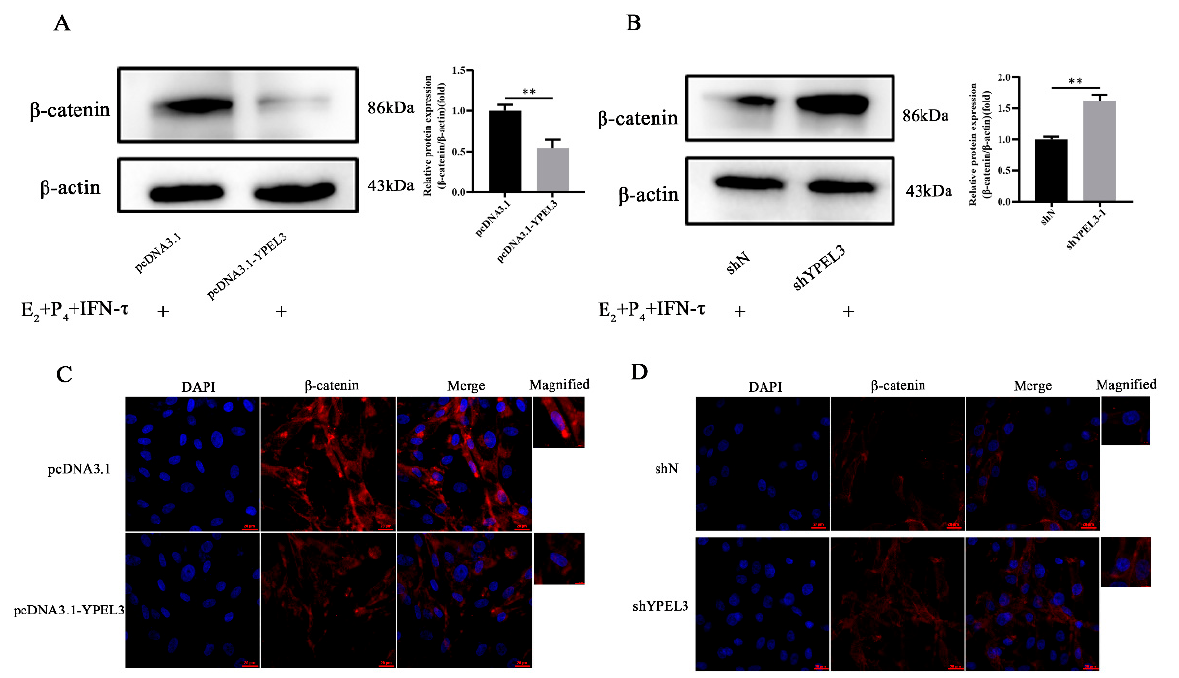
Figure 5. YPEL3 regulated the Wnt/ β -catenin signaling pathway. Western blot analysis of the expression of β -catenin in gEECs with YEPL3 silencing ( A ) and YEPL3 overexpression ( B ) and treated with E 2 , P 4 and IFN- τ . Confocal microscope images of immunohistochemical staining of β -catenin expression and nuclear translocation in gEECs with YEPL3 overexpression ( C ) or YEPL3 silencing ( D ) and treated with E 2 , P 4 and IFN- τ . ** p < 0.01.